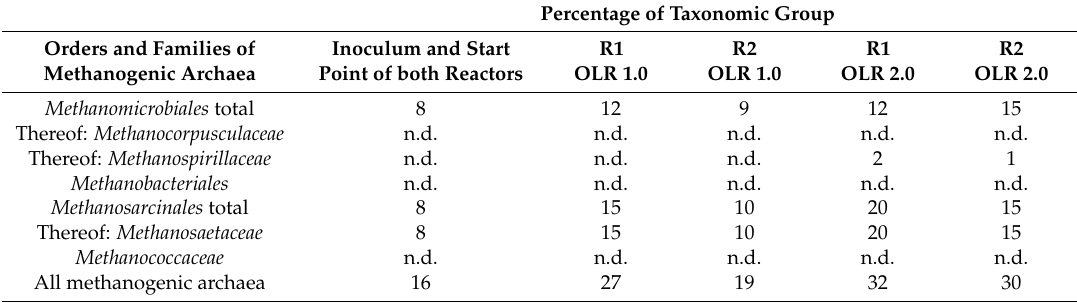
Table 2. Quantitative measurements of methanogenic archaea in continuous lab-scale reactors R1 treating mixed sludge (MS) and food waste (OFMSW) and R2 treating the mixed sludge only, both at an OLR of 1 kg/m 3 /d and 2 kg/m 3 /d (n.d., not detected).